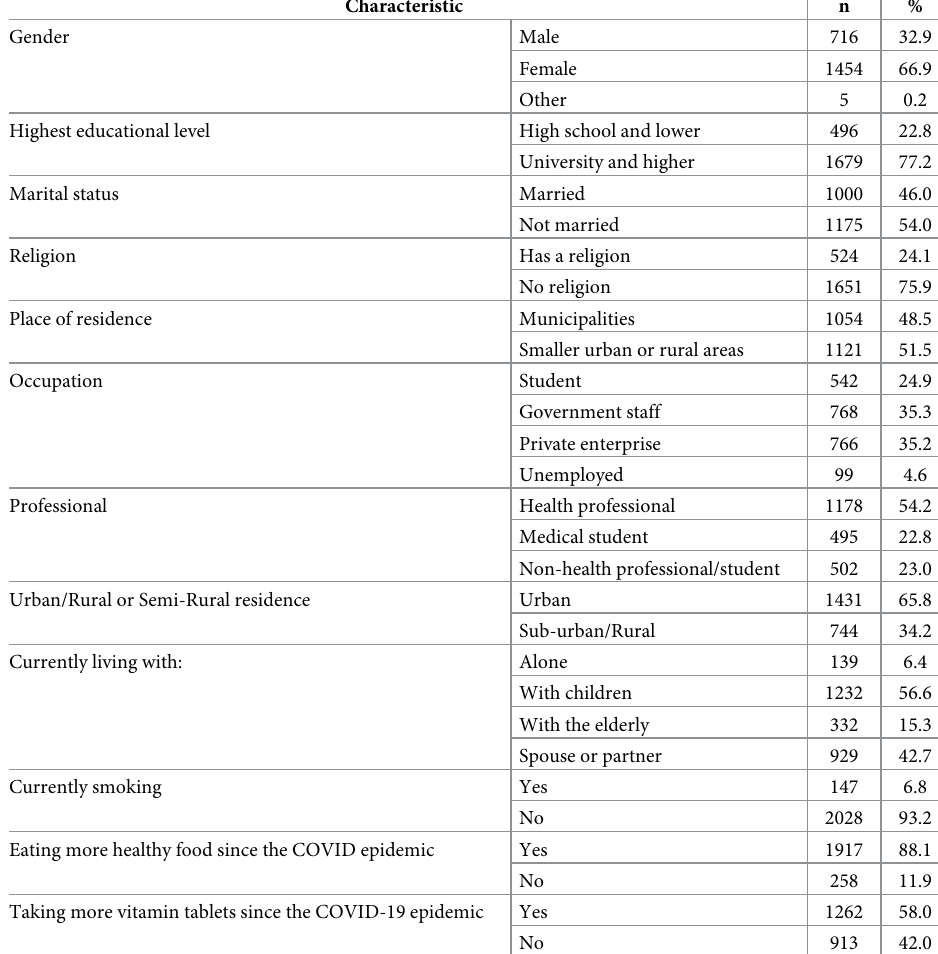
Table 1. Characteristics of study participants (n =